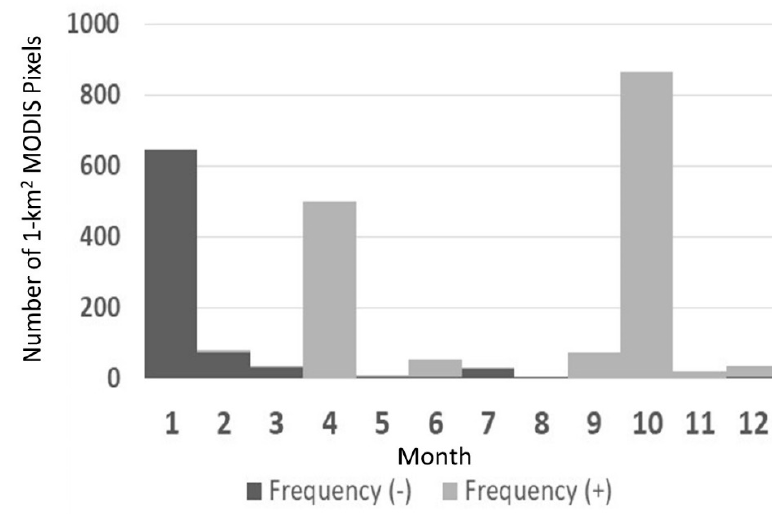
Figure 9. Monthly distribution of negative and positive breakpoints detected from structural change analysis of LST in 2005 for the DRECP study area MODIS 1-km time series.